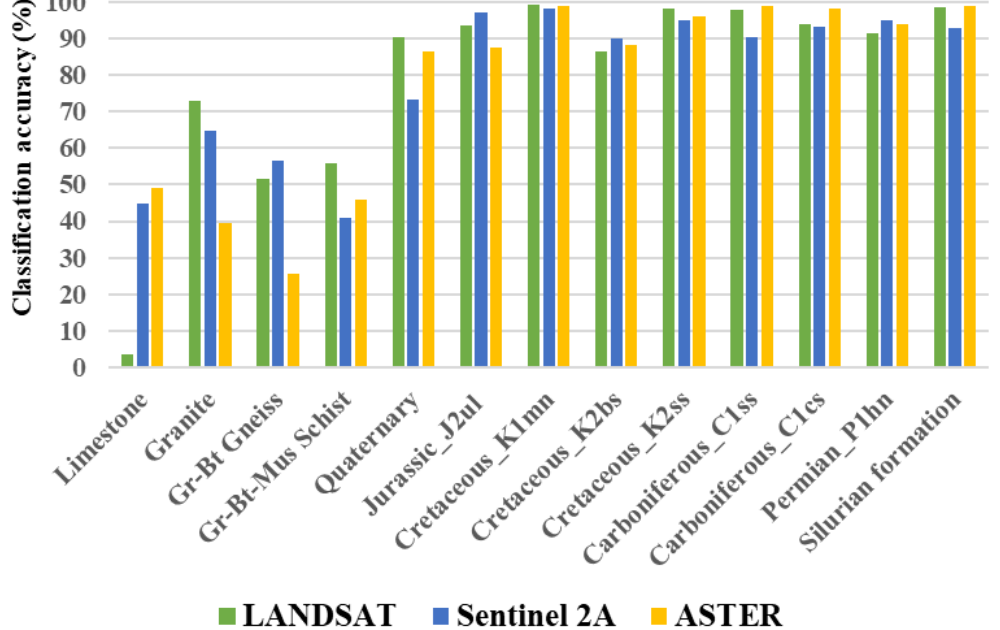
Fig. 14. The classification accuracies of the Landsat, ASTER, Sentinel images using the SVM